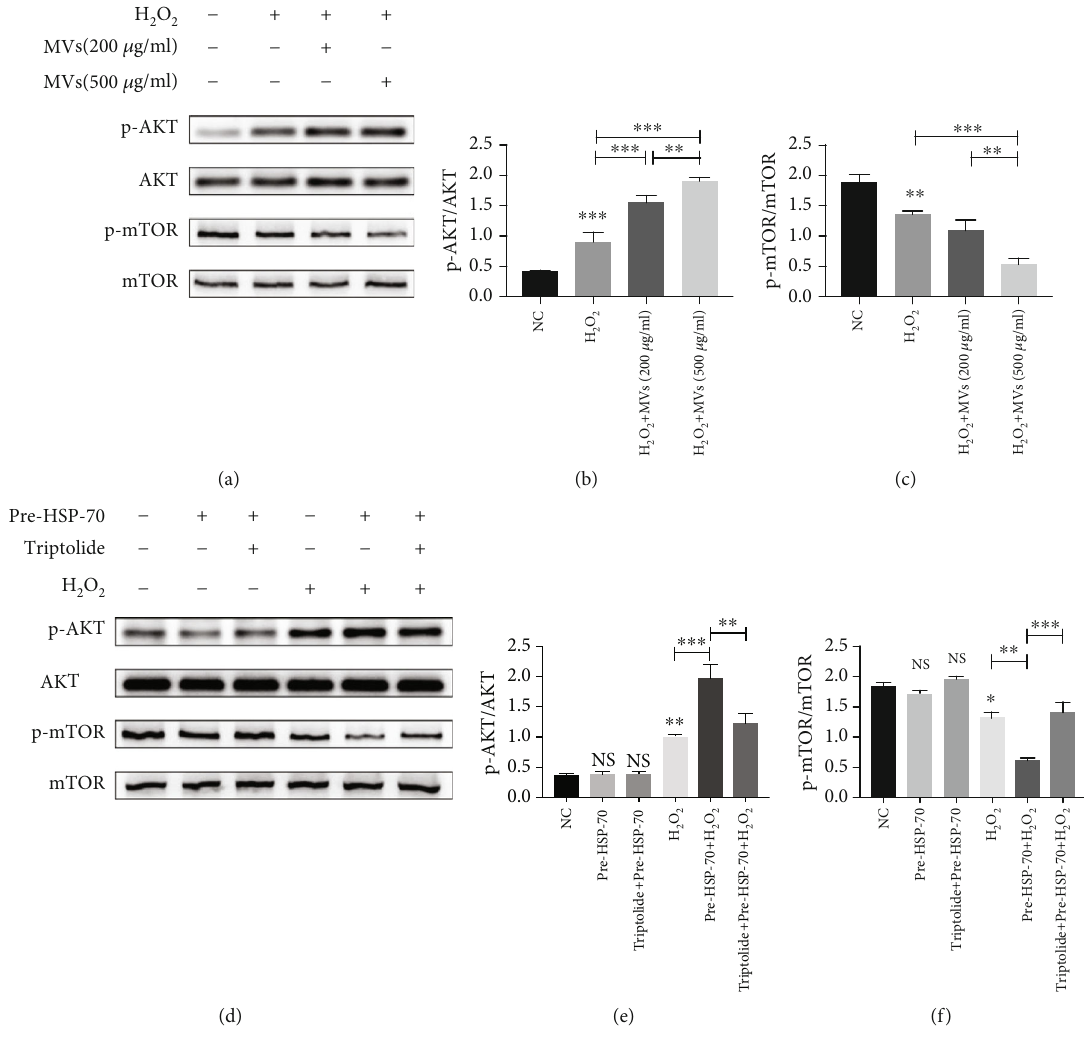
Figure 8: hESC-NSC-derived MVs regulate Akt and mTOR pathways by transporting HSP-70 after H western blot images showing the protein levels of AKT, p-AKT, mTOR, and p-mTOR. β -Actin was used as an internal control. Every experiment was repeated at least three times. Error bars indicate mean ± SD ( ∗ P < 0 : 05 ; ∗∗ P < 0 : 01 ; ∗∗∗ P < 0 : 001